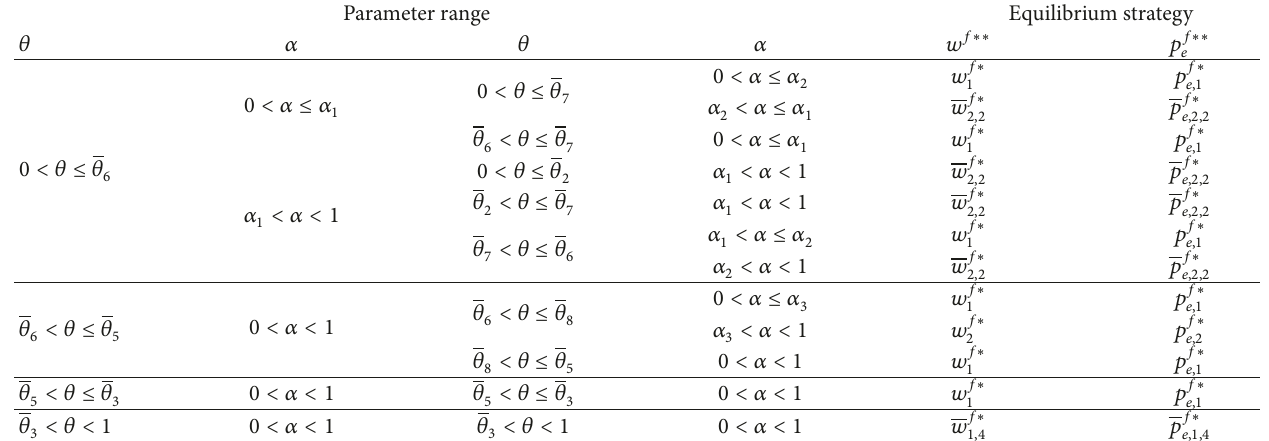
Table 4: The complete equilibrium strategy of the manufacturer. Parameter range Equilibrium